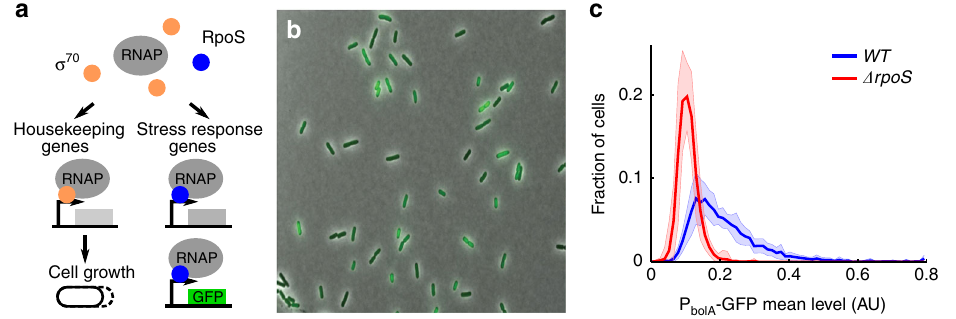
Fig. 1 The stress response master regulator, RpoS, is heterogeneously expressed in unstressed cells. a Schematic of the role of sigma factors σ 70 and RpoS in promoting growth and activation of the stress response regulon, respectively. Also illustrated is the RpoS reporter, a transcriptional fusion to a stress response promoter. b Representative phase contrast and fl uorescence composite image of RpoS reporter, P bolA -GFP , in WT ; channel ranges chosen for display. c Histograms of mean GFP per cell (line: mean, shaded region: ± std dev) in WT (10 biological replicates, 4037 cells, mean = 0.21, CV = 0.51) and Δ rpoS (9 bio. reps., 4069 cells, mean = 0.11, CV = 0.27) strains. The long tail of high RpoS expression present in the WT is absent in the